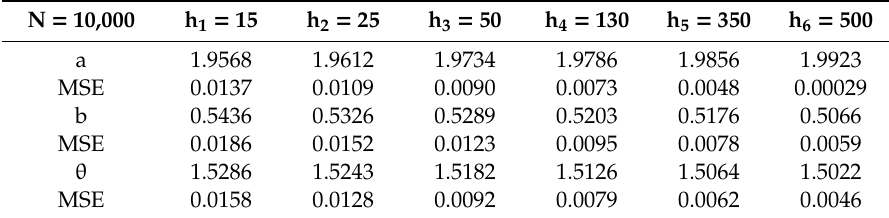
( P ) test for OB-F model against their theoretical values h